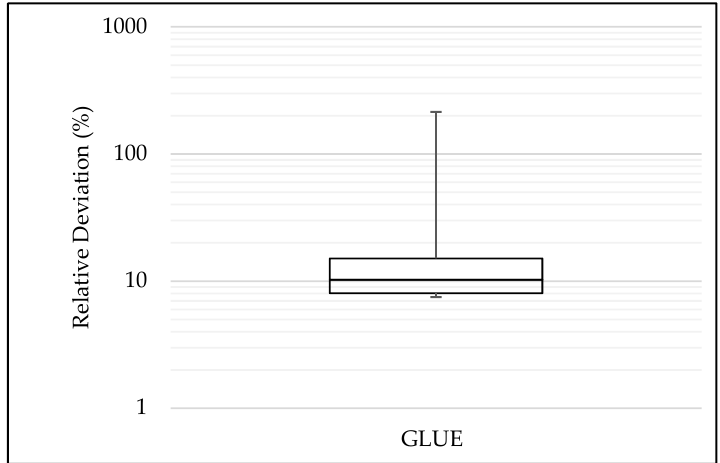
Figure 5. Boxplot of relative deviation (logarithmical scale)—GLUE.